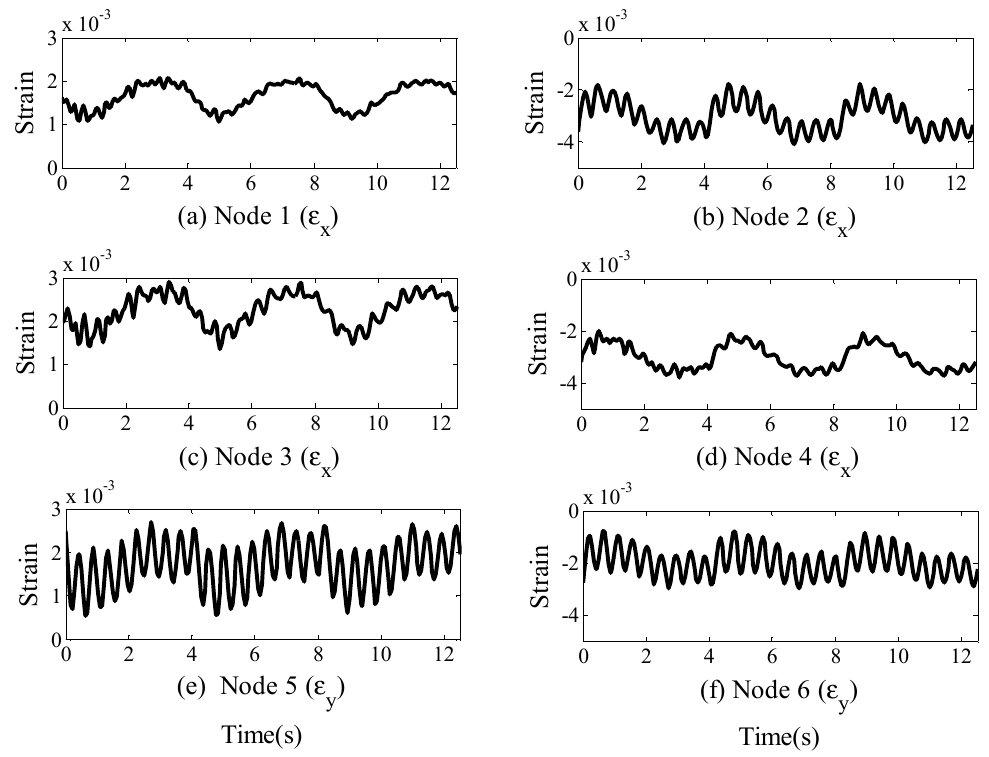
Figure 4. Strain time histories of Nodes 1 – 6 ( a–f ).